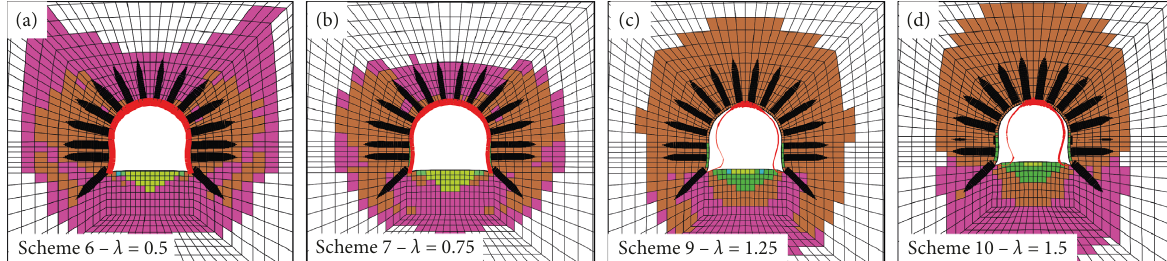
Scheme 6 – λ = Figure 8: Surrounding rock plastic zones and supporting structure inner force diagrams of (a) Schemes 6, (b) Schemes 7, (c) Schemes 9, and (d) Schemes 10 at the 50 th